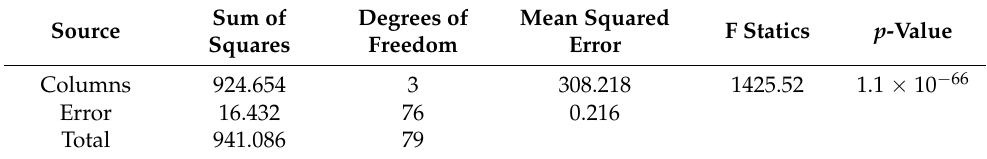
Table 4. Analysis of variance